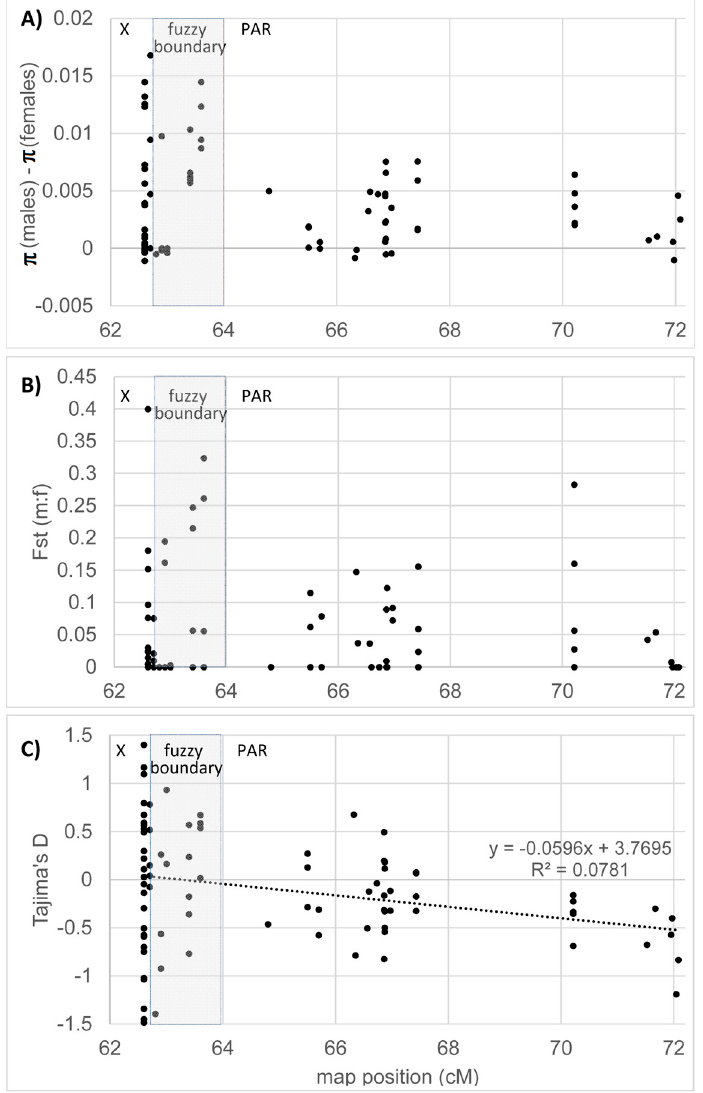
Figure 1. Patterns of DNA polymorphism in S. latifolia males and females at the genes adjacent to the PAR boundary. ( a ) The difference in average heterozygosity ( π ) between males and females; ( b ) Population differentiation (F st ) between males and females and ( c ) Tajima’s D for the entire sample.